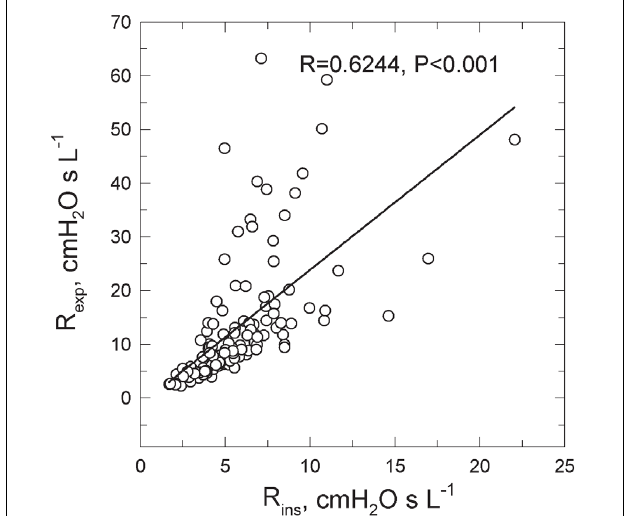
FIGURE 2 | Relations between the inspiratory ( R ins ) and the expiratory ( R exp ) resistance measured in 130 COPD patients spontaneously breathing at rest.